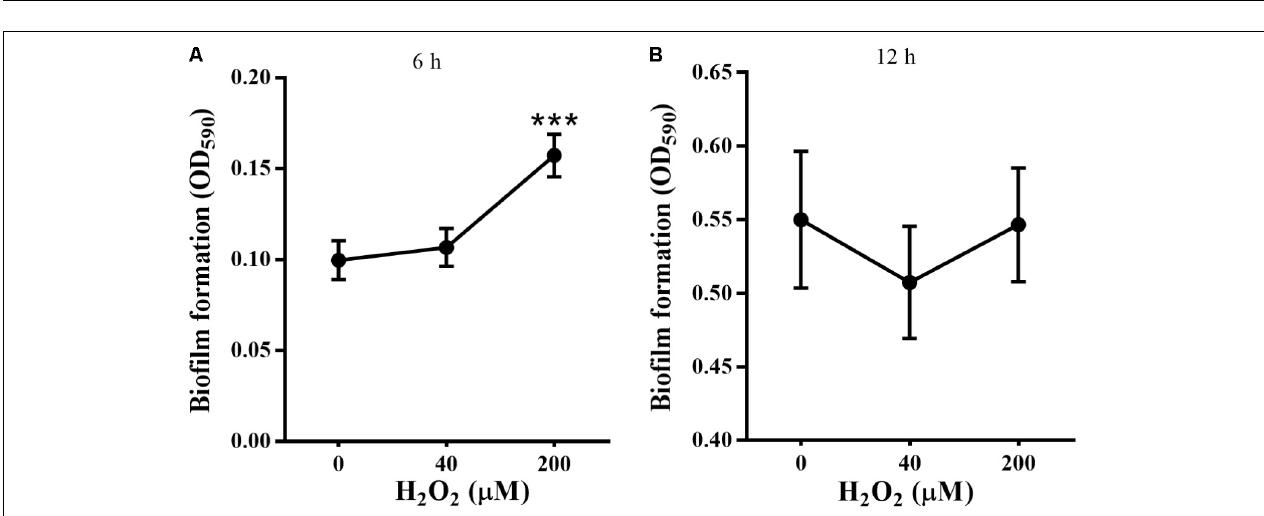
FIGURE 2 | Effect of exogenous H 2 O 2 on the biofilm formation by P. putida MnB1. Biofilm formation by P. putida MnB1 was quantified by CV staining with absorbance at 590 nm. Cells were incubated with H 2 O 2 (0, 40, and 200 µ M) for 6 h (A) and 12 h (B) ( n = 6), respectively. Data were expressed as mean ± SEM. Significance, ∗∗∗ P < 0.001 vs. control group (0 µ M H 2 O 2 ).